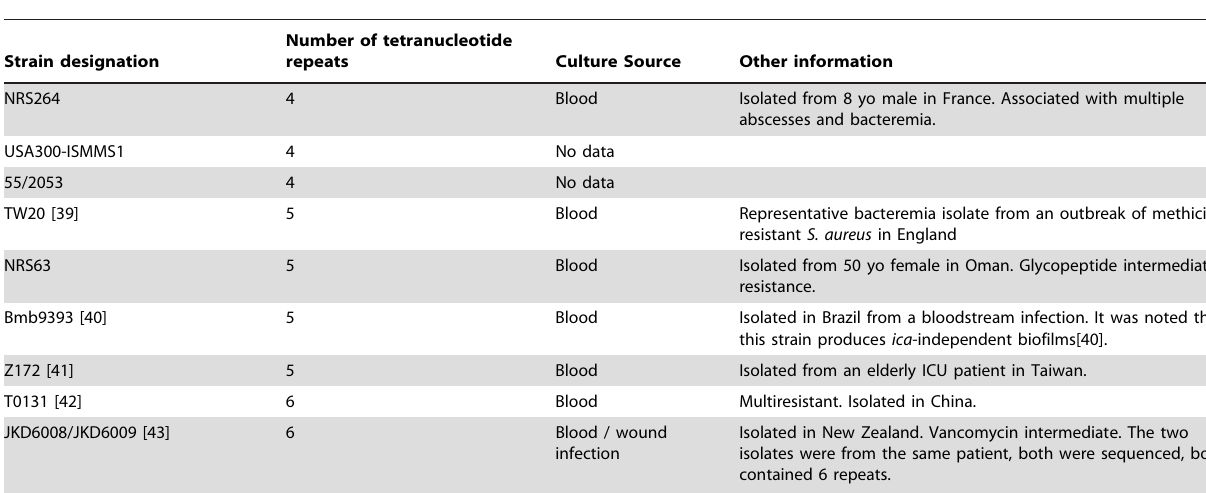
Table 1. Information about strains with variable numbers of tetranucleotide repeats.